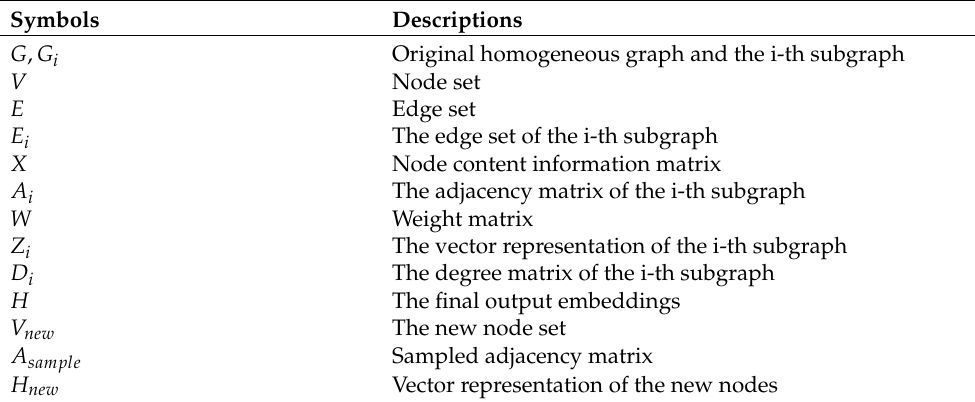
Table 2. The notations in this